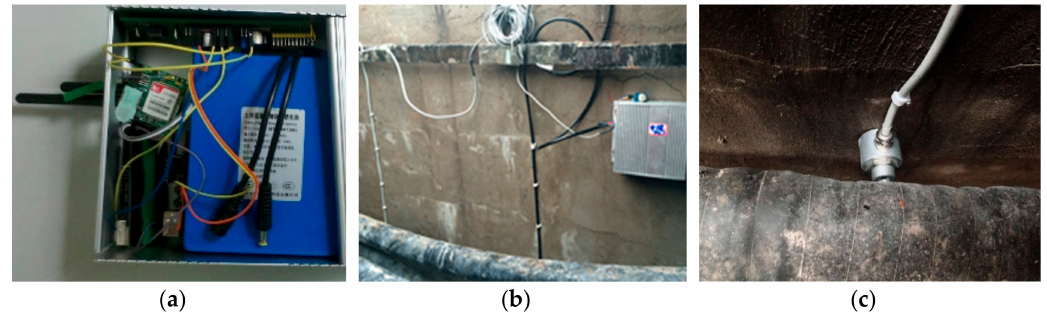
Figure 11. Online monitoring system. ( a ) Internal structure, ( b ) installation appearance of monitoring system, and ( c ) temperature